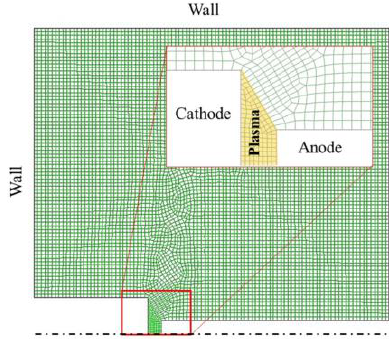
Figure 10. Computational domain and grid with a zoom of the gap region.